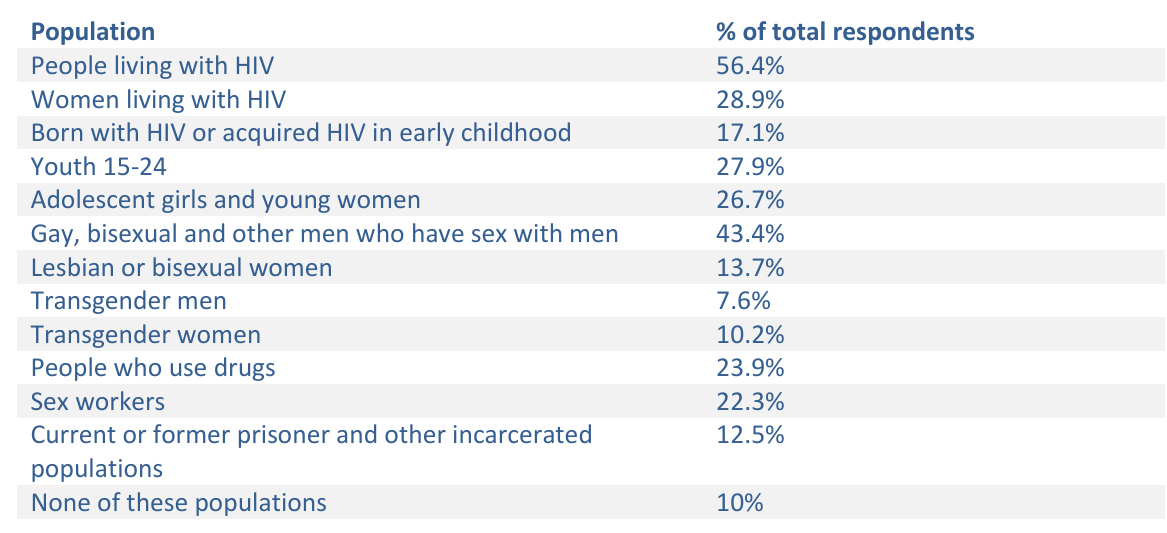
Table 1. % of total respondents by population (n=502)